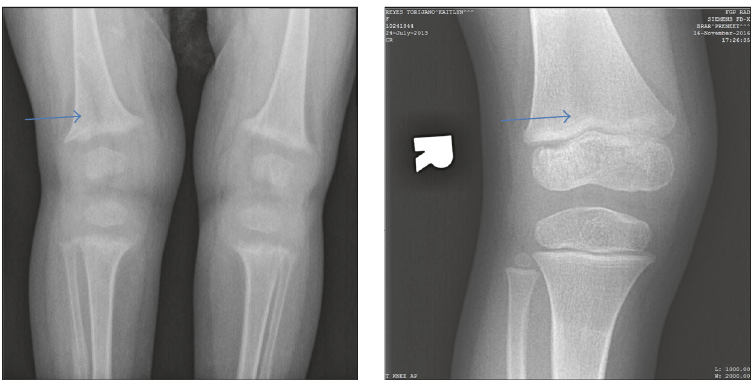
(a) Radiograph of the knees at initial presen- tation. AP radiograph of both knees. There is widening of the physes above the knee with splaying and fraying of the metaphyses. No fracture or dislocation is seen. Bones appear demineralized. Impression: findings compat- ible with rickets. The blue arrow points at the fraying at the end of the bones